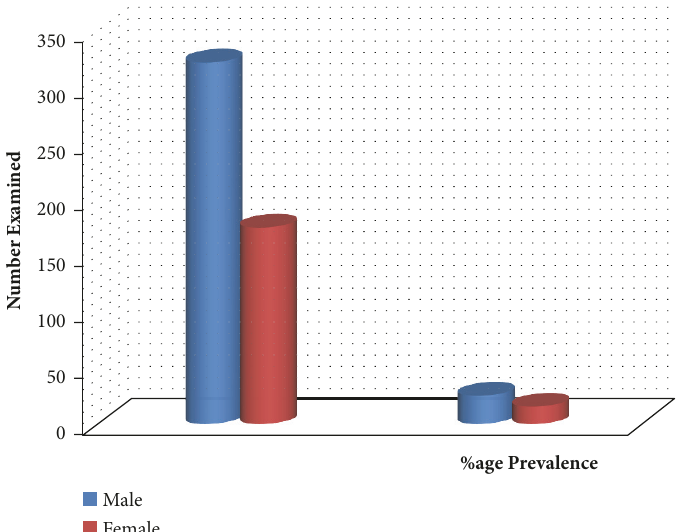
Figure 2: Prevalence of infection by